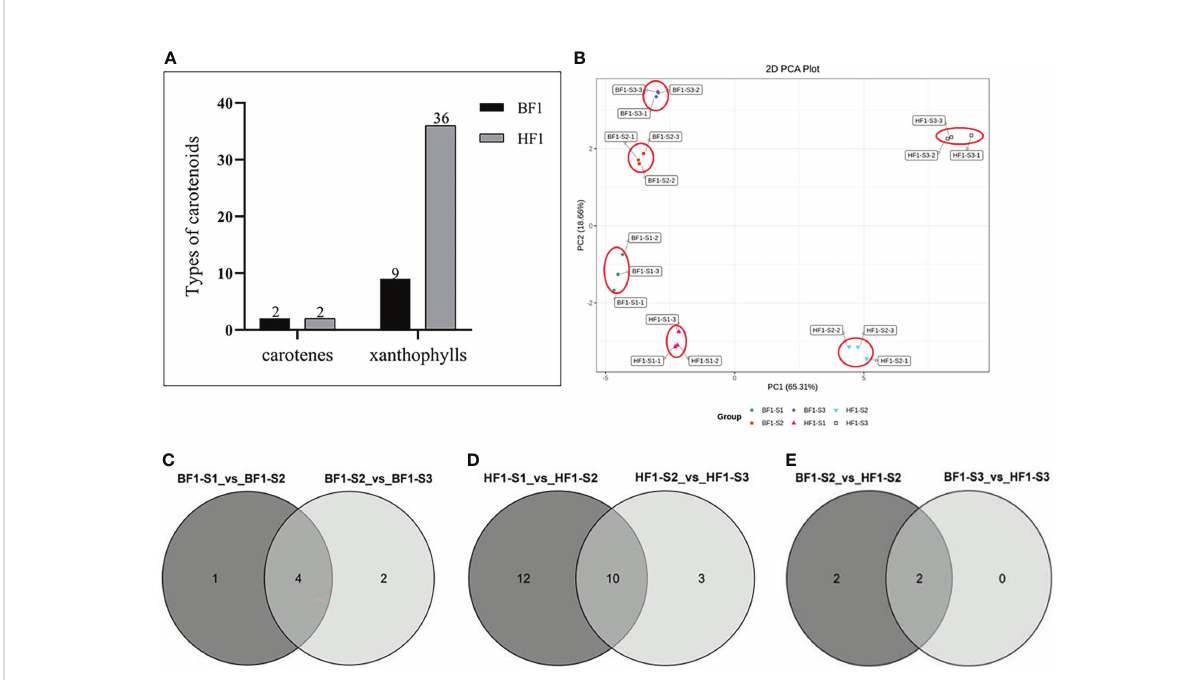
FIGURE 3 Targeted carotenoid metabolomic analysis in Hybrid F1 generation. (A) Detection of carotenoid species in F1 generation of peach hybrid. (B) Principal component analysis (PCA) biplot showing carotenoid clusters of the furit developmental stages of the peach hybrid F1 generation. (C) Venn diagram of differential carotenoid metabolites in the BF1 fruit development stages. (D) Venn diagram of differential carotenoid metabolites in the HF1 fruit development stages. (E) Venn diagram of differential carotenoid metabolites in fruit development stages of BF1 vs